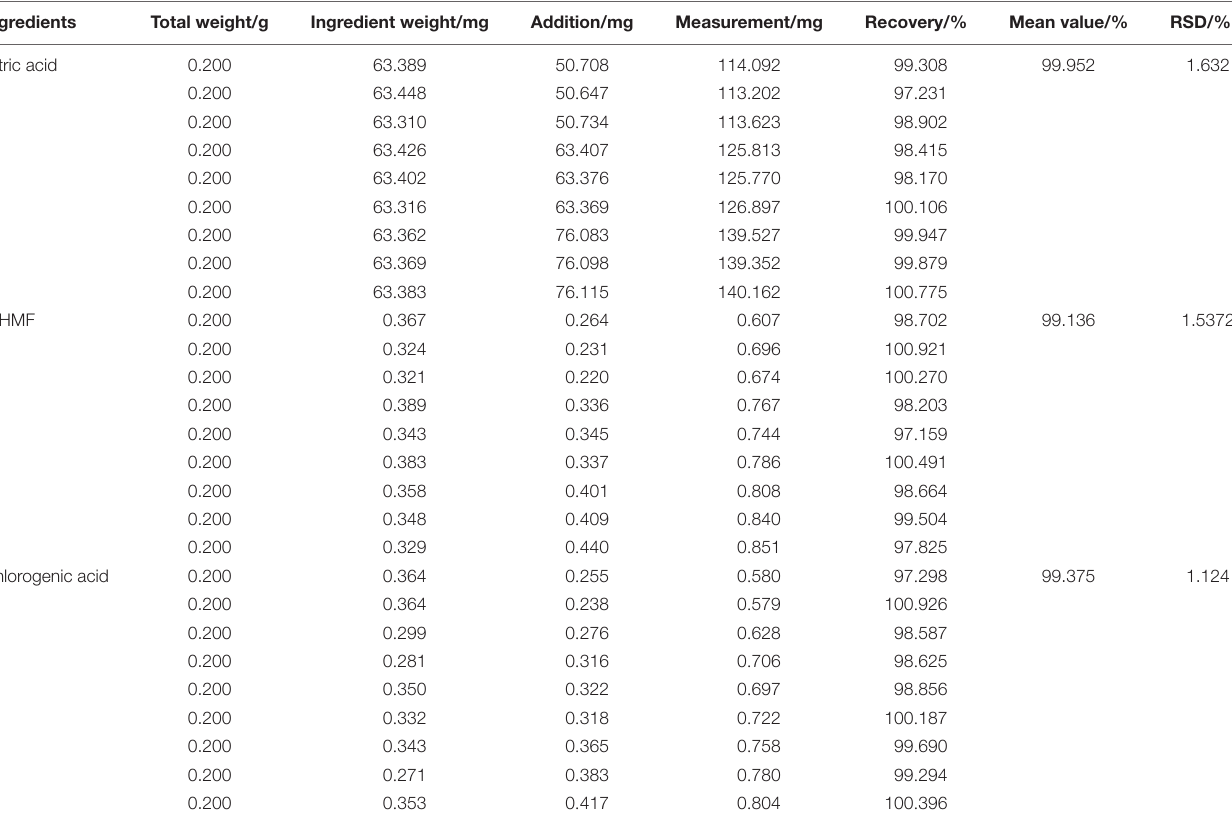
TABLE 2 | HPLC analysis of EFM at different batches.